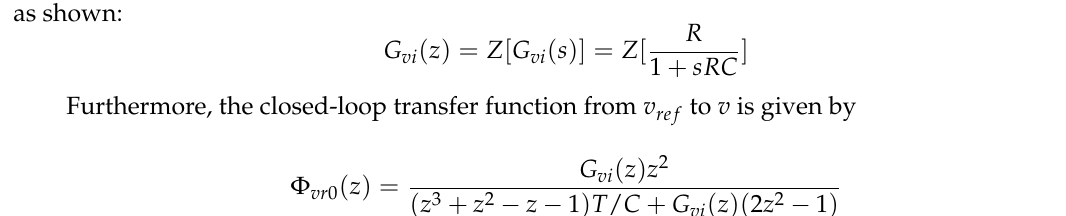
Figure 4. Ideal discrete-time small signal model of SCB controlled flyback converter.